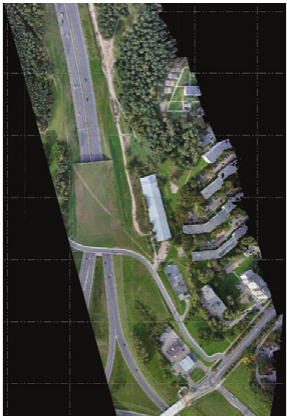
Fig. 6. The fragment of generated orthophoto at experimental